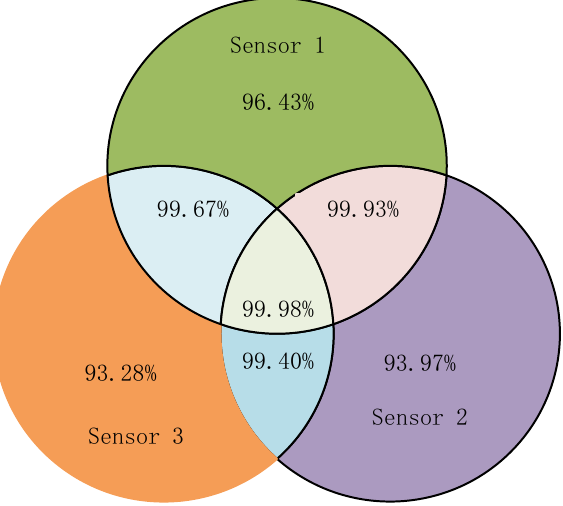
Figure 15. Accuracy before and after multi-sensor